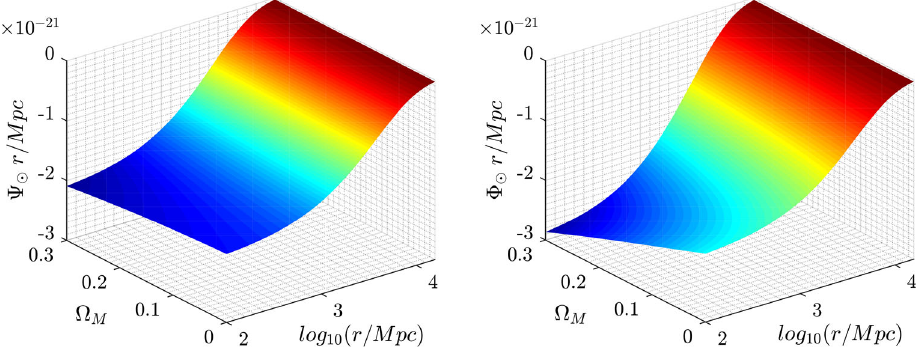
Fig. 3 Plot of (cid:5) (cid:9) ( r ) r / Mpc and (cid:4) (cid:9) ( r ) r / Mpc versus (cid:2) M and log ( r / Mpc ) for one particle with mass equal to one solar mass for the potential